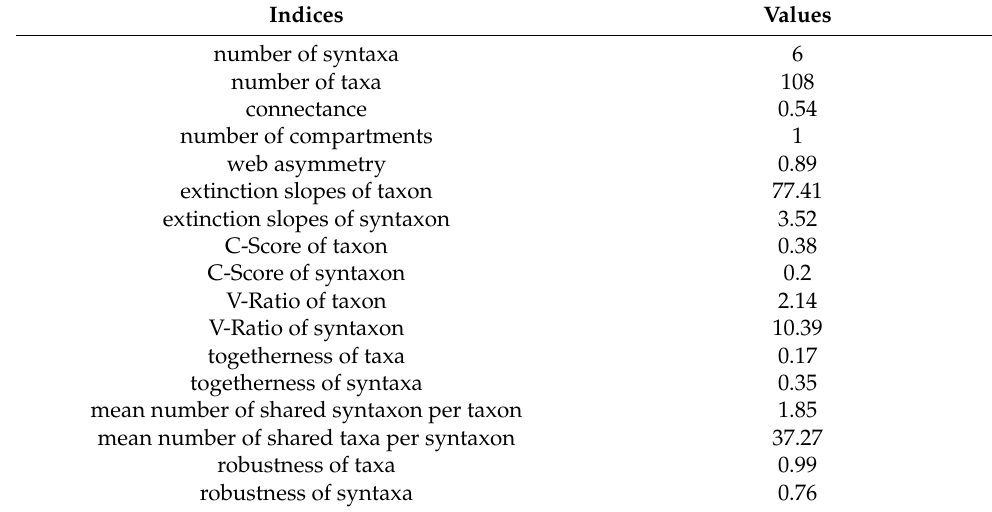
Table 1. All selected indices for the taxon-syntaxon bipartite network of study